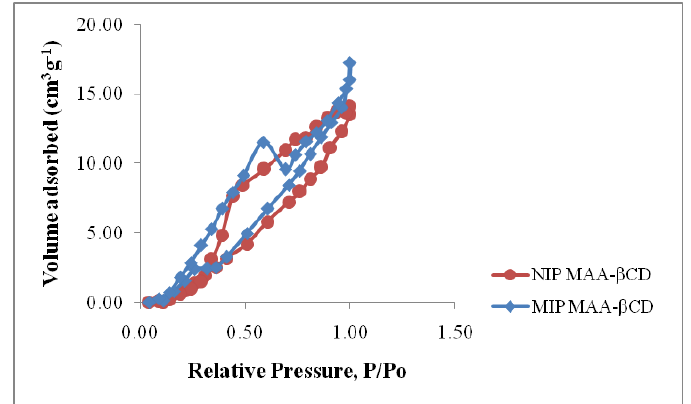
Figure 2. Nitrogen adsorption/desorption profiles of MIP MAA-βCD and NIP